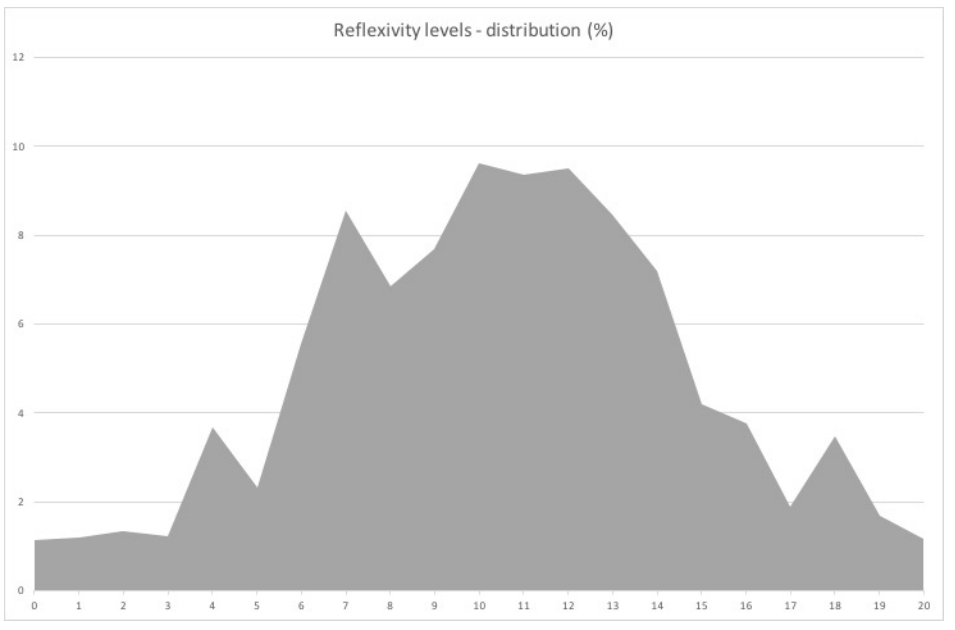
Figure 2. Distribution of the reflexivity levels.